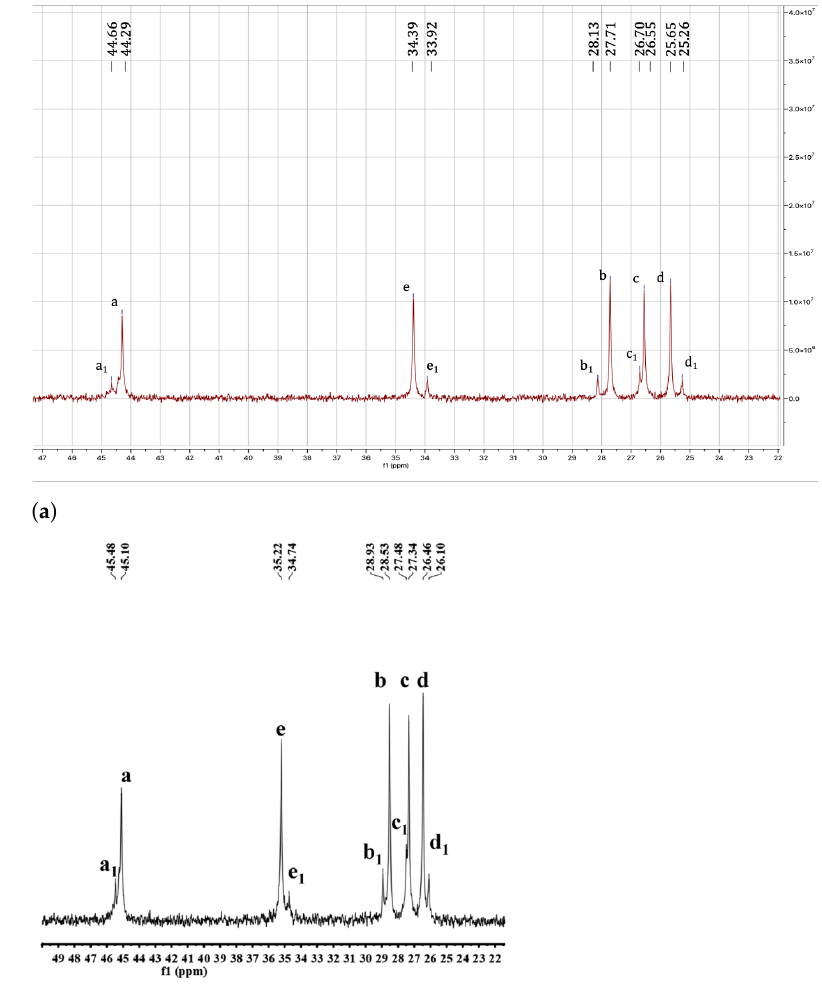
Figure A3. A comparison between the characteristic peaks of the methylene groups a to e and a 1 to e 1 of ( a ) the qualitative 13 C-NMR spectrum of the employed HMWPA copolymer and ( b ) the quantitative 13 C-NMR spectrum for a random PA 6/66 copolymer with a PA 66 molar comonomer fraction of 15% as obtained by Tang et al. (2018)